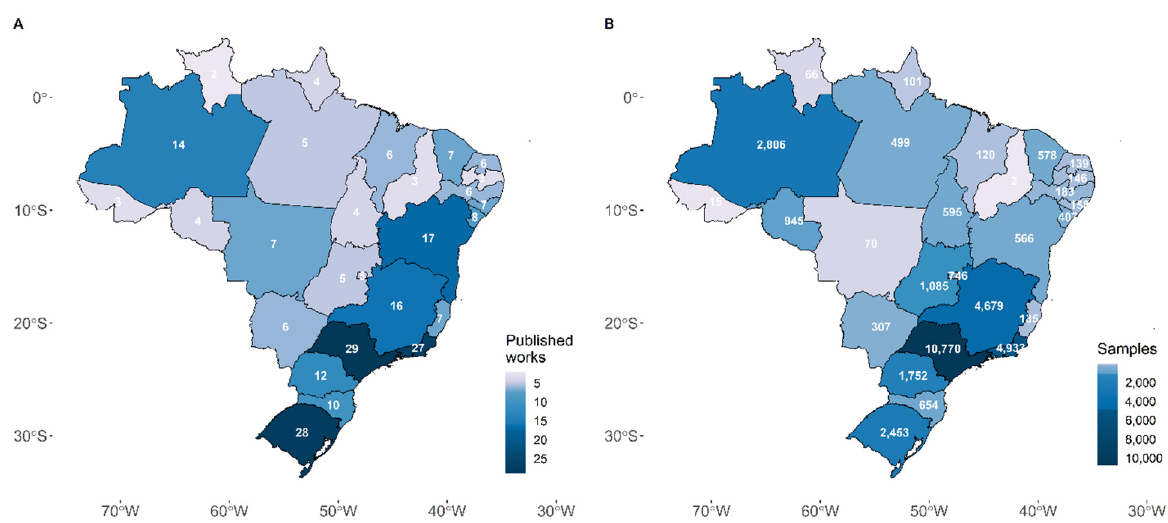
Figure 1. Spatial overview of the genomic surveillance in Brazil. ( A ) The number of published articles with samples from each Brazilian State. ( B ) The number of characterised samples from each Brazilian State in the published reports.